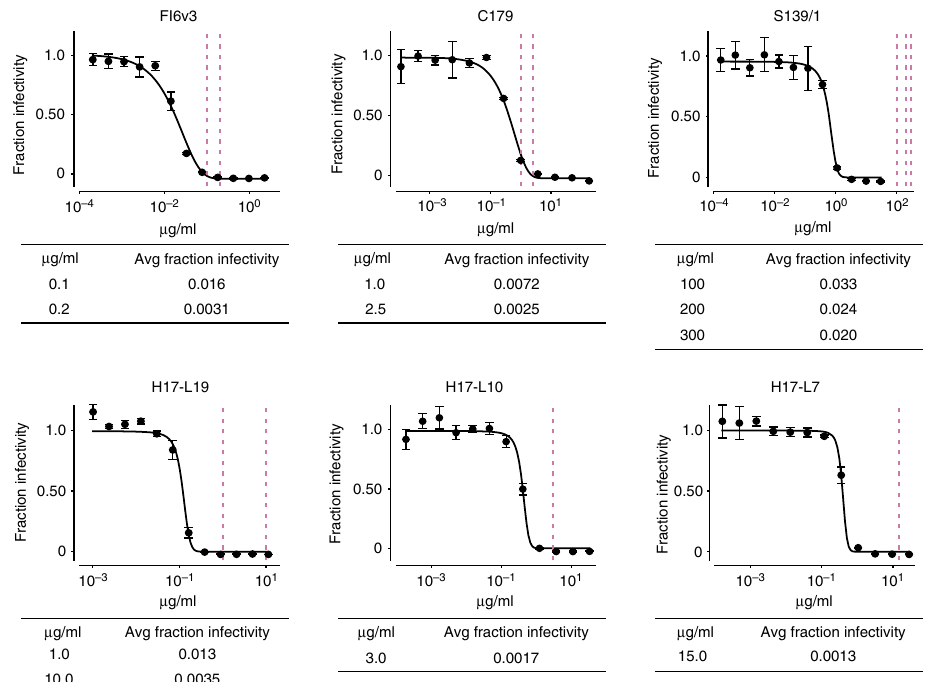
Fig. 3 Neutralization of wildtype virus by each antibody, and the fraction of mutant library virions surviving at each concentration used in our experiments. The curves show neutralization of the wildtype A/WSN/1933 virus. Each point represents the mean and standard deviation of three measurements. The vertical dotted lines show the concentrations of antibody that were then used in the mutant virus library selections, and the tables give the overall fraction of the mutant virus libraries that survived at each concentration, determined by qRT-PCR. As described in the text, the antibody concentrations were chosen to give similar fractions of the mutant virus libraries that survive, rather than to fall at uniform positions on the neutralization curves of the wildtype